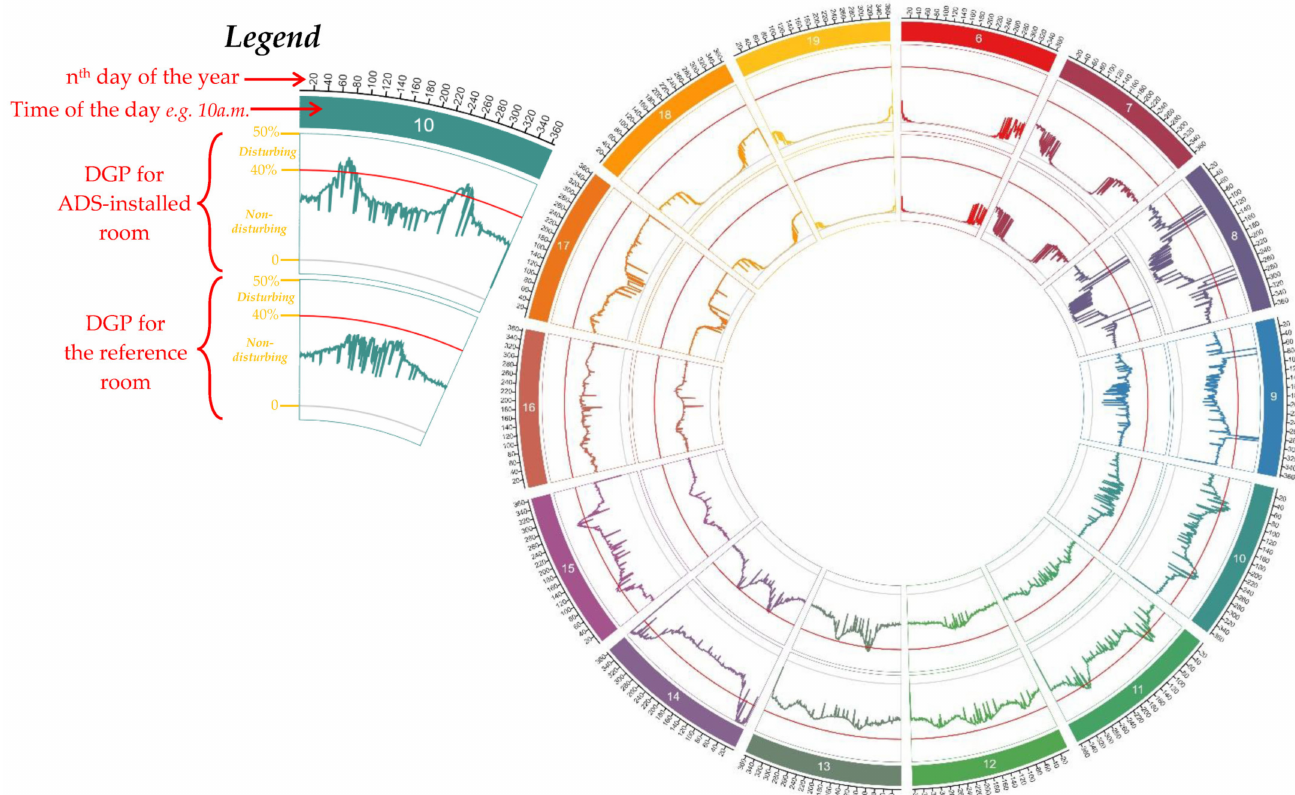
Figure 10. A yearly measurement and comparison between the reference room and ADS-installed daylight glare probability on an hourly